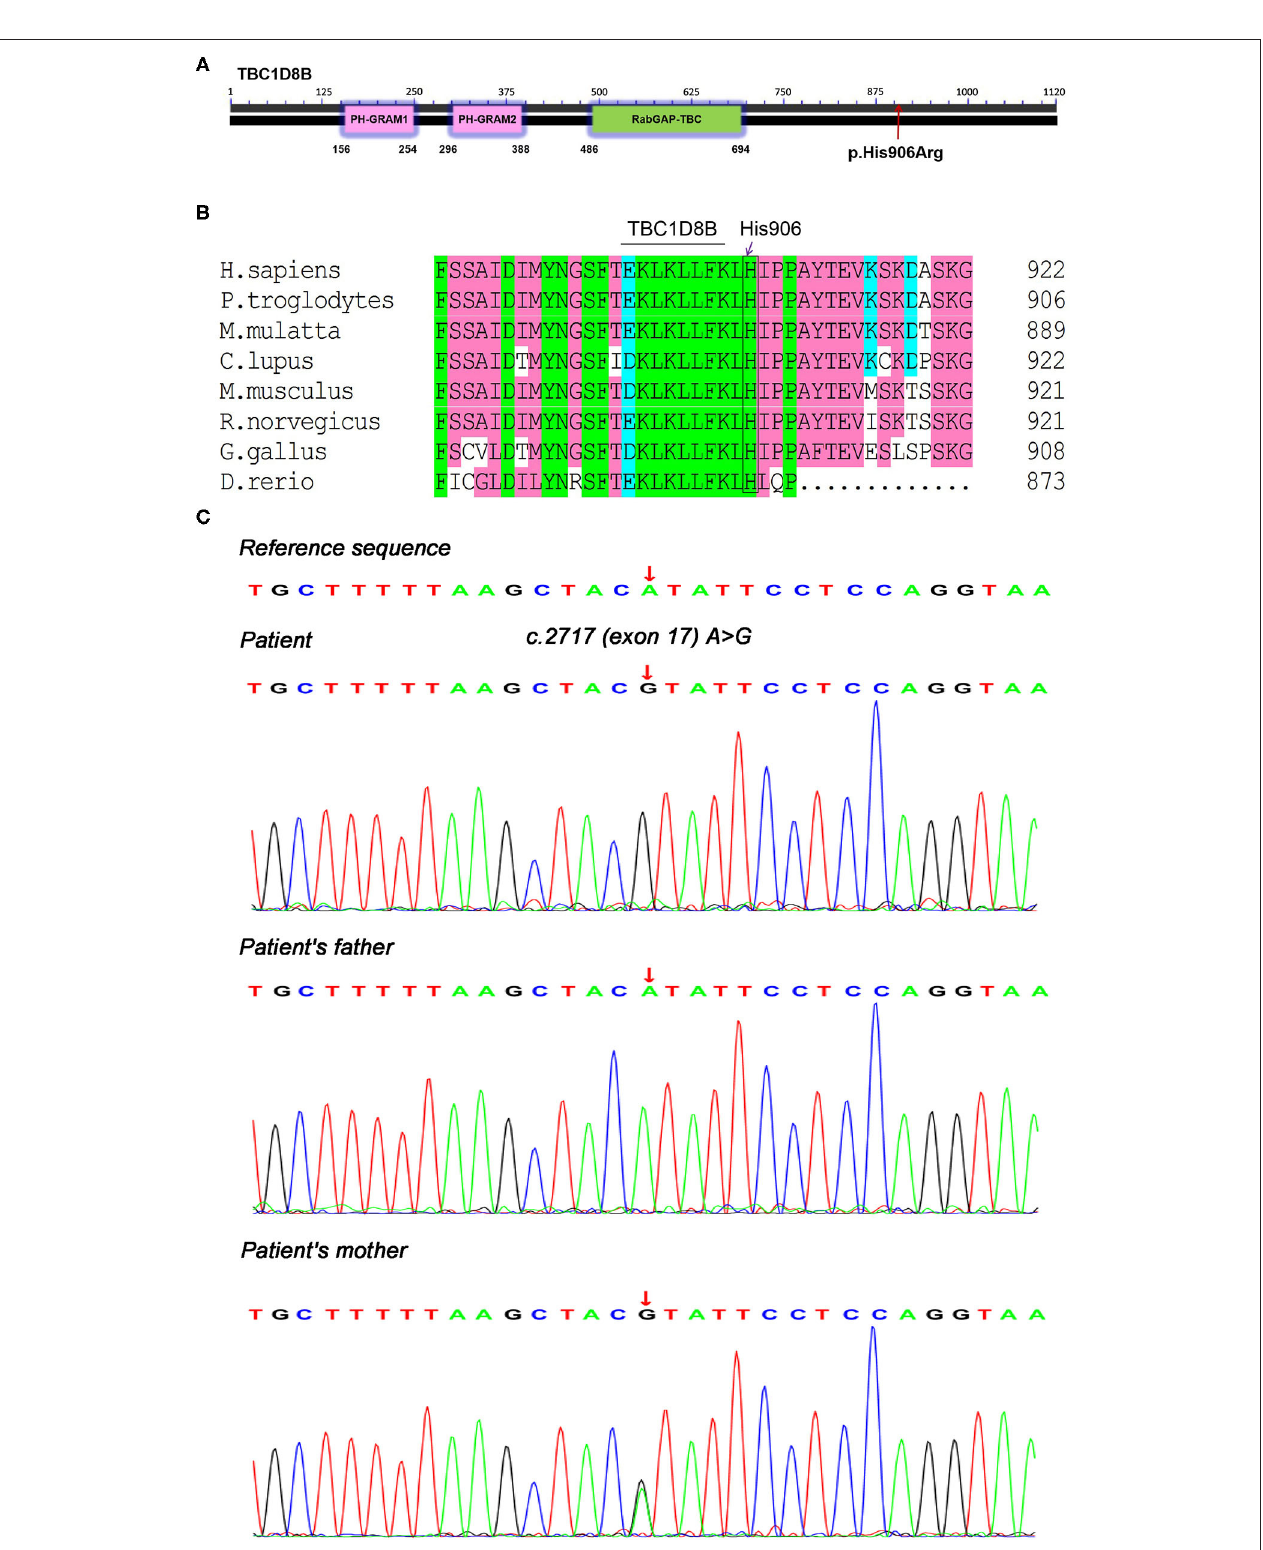
FIGURE 1 | Genetic testing and conservation of the TBC1D8B sequence in different species. (A) TBC1D8B protein structure and location of the child’s p.His906Arg mutation, (B) amino acid sequence conservation in different species, and (C) trio whole-exome sequencing results, showing a hemizygous mutation, c.2717A > G (p.His906Arg), in the TBC1D8B gene of the child and the mother.